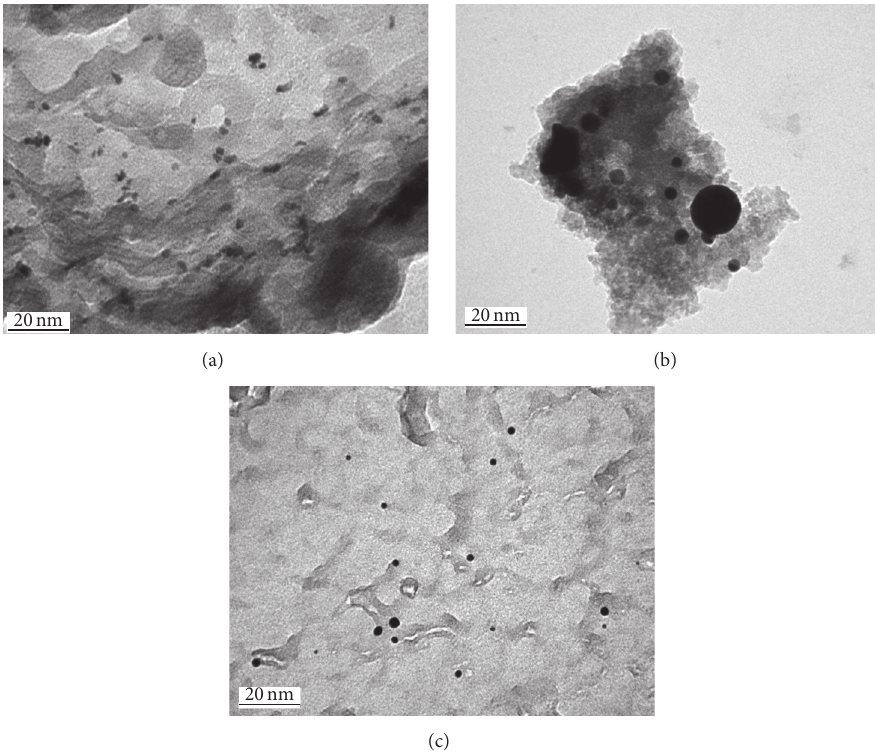
Figure 6: Representative TEM Micrograph for Au/P[VBTACl]/M catalysts after five recycles. (a) M: Al; (b) M: Ti; (c) M: